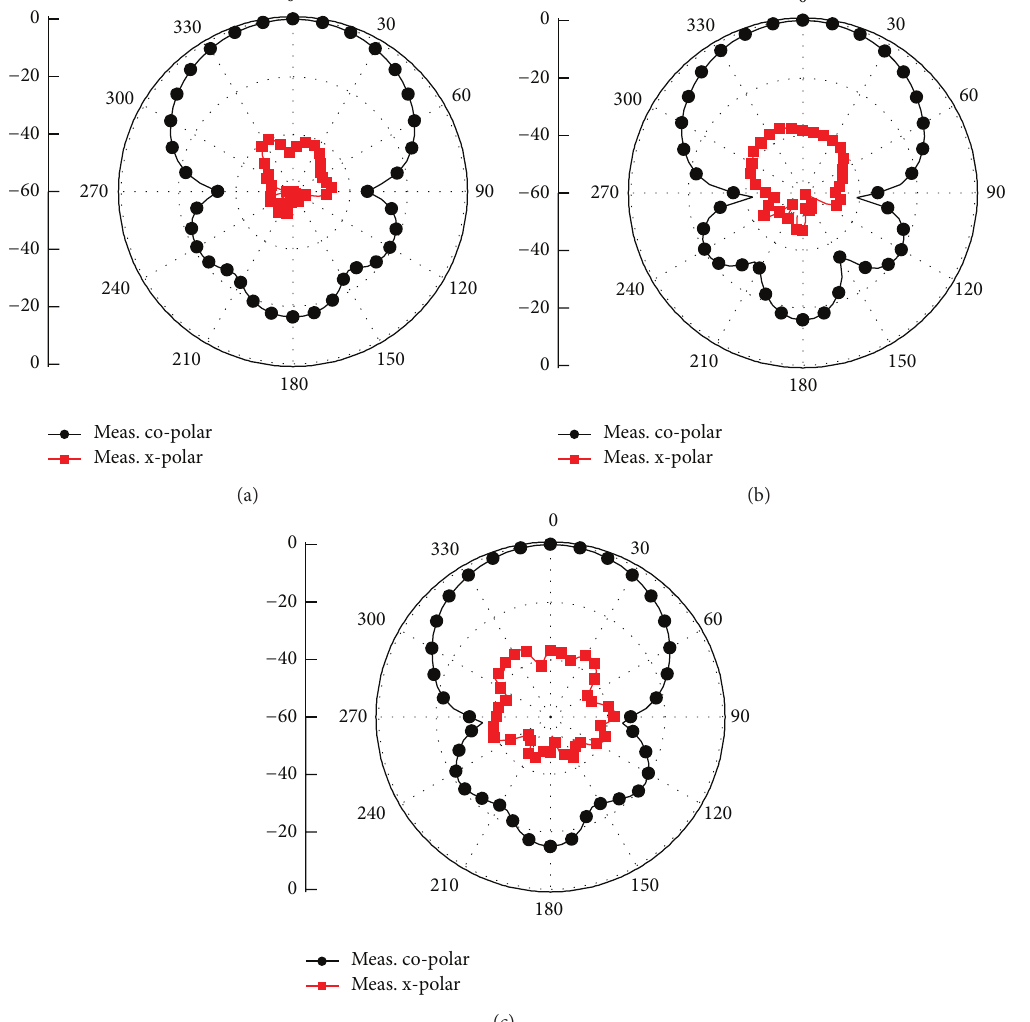
Figure 8: Measured radiation patterns for E-plane (xoz plane) at (a) 2.5 GHz, (b) 3GHz, and (c) 3.5 GHz for Port